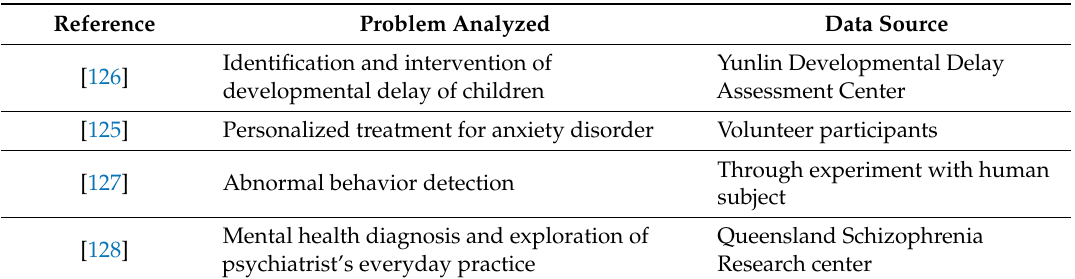
Table 8. List of data mining application in mental health with data